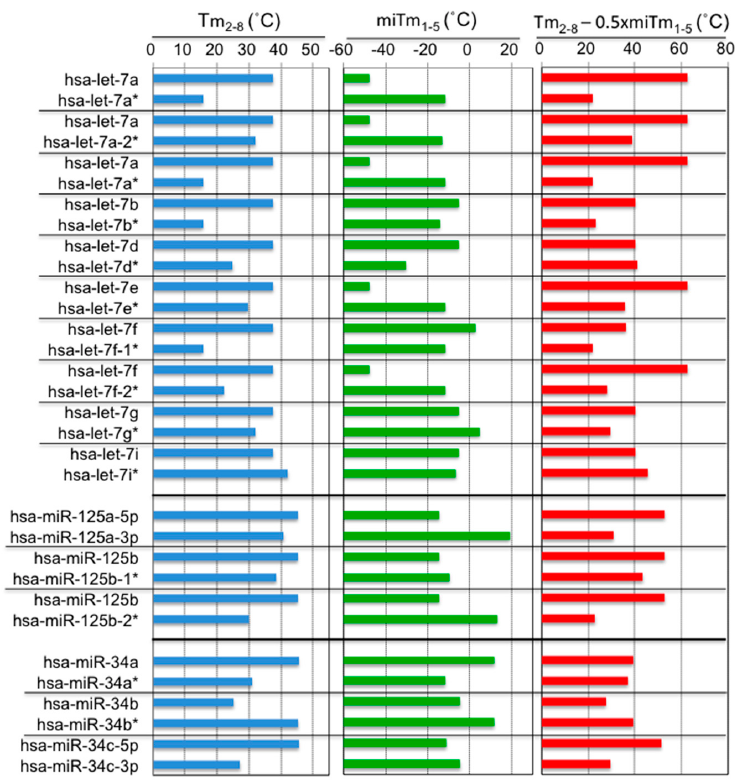
Figure 3. Calculated T m 2–8 , mi T m 1–5 , and T m 2–8 − 0.5 × mi T m 1–5 values for the miRNA families let-7, miR-125, and miR-34.